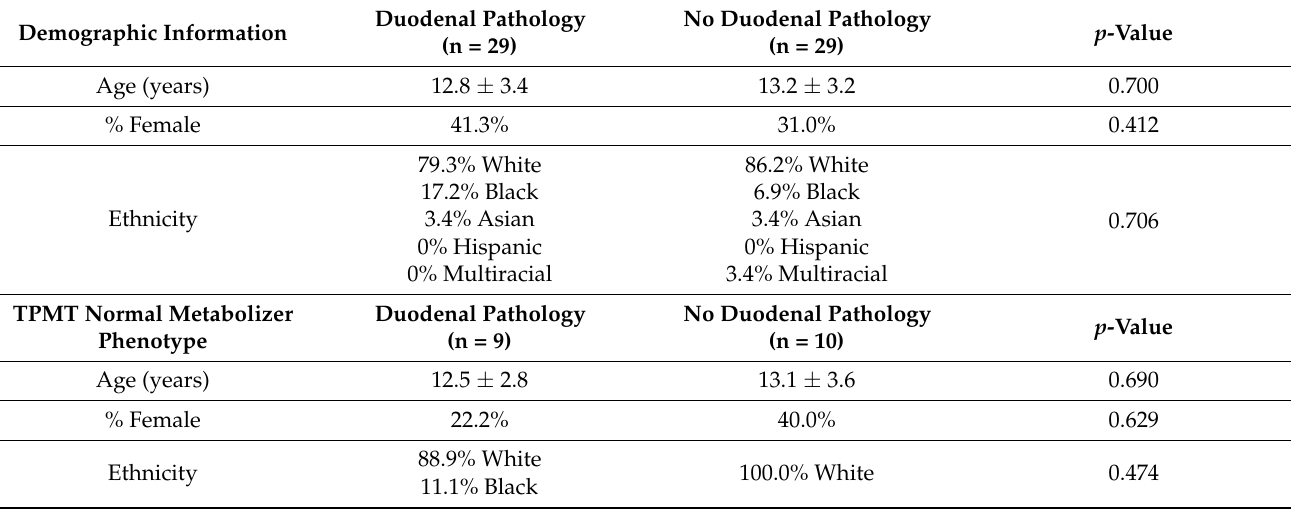
Table 1. Patient demographics at the time of Crohn’s disease diagnosis for all patients (n = 58), and the subset with the normal metabolizer phenotype for thiopurine methyltransferase (TPMT) who received azathioprine dosing based on TPMT phenotype